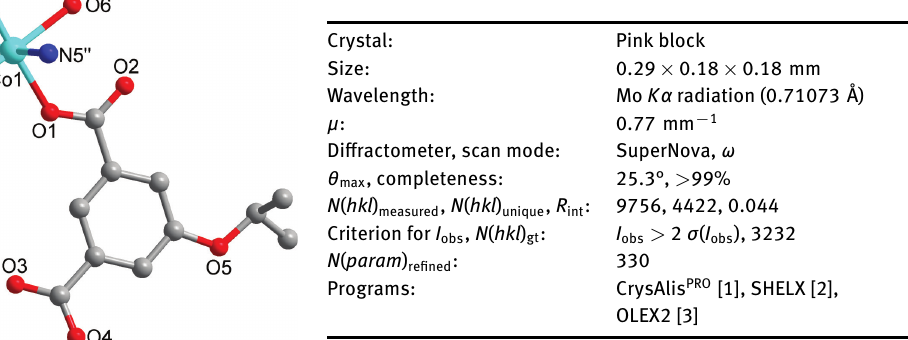
Table 1: Data collection and handling.